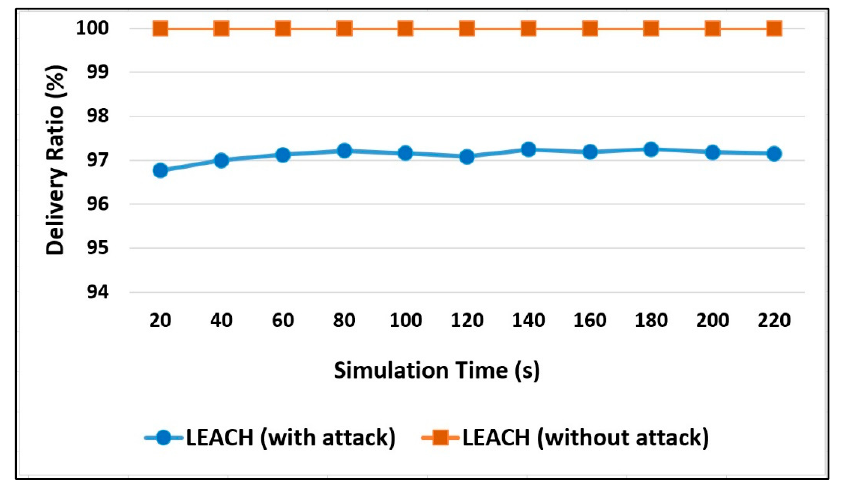
Figure 10. Packet delivery ratio measurement.